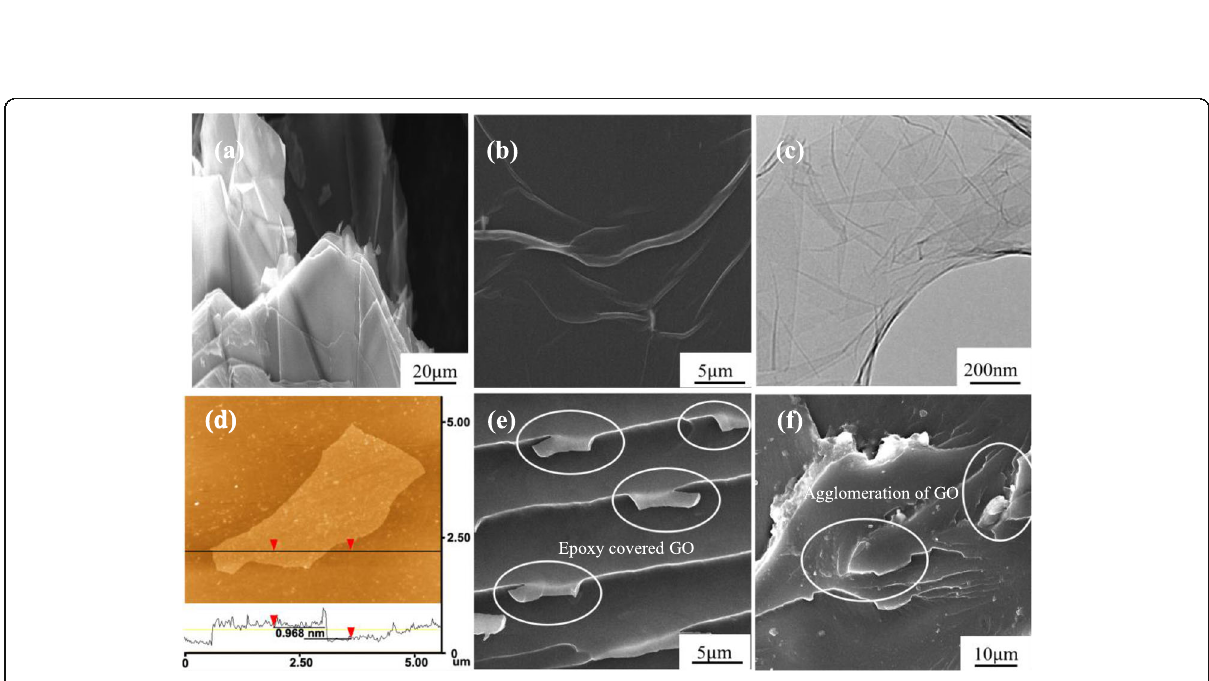
Fig. 3 SEM images of a graphite flakes. b GO sheets. c TEM image of GO. d AFM image of GO. e GO sheets in epoxy resin (0.5 wt%). f GO sheets in epoxy resin (1.0